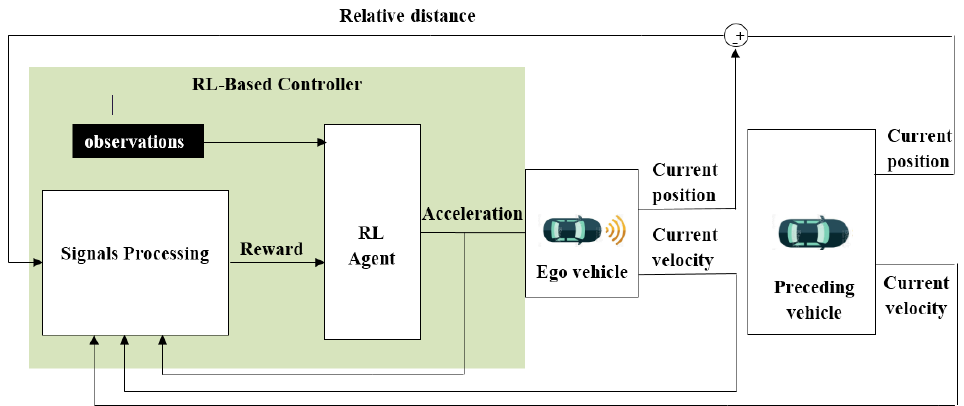
Figure 11. Overall diagram of the control system-RL